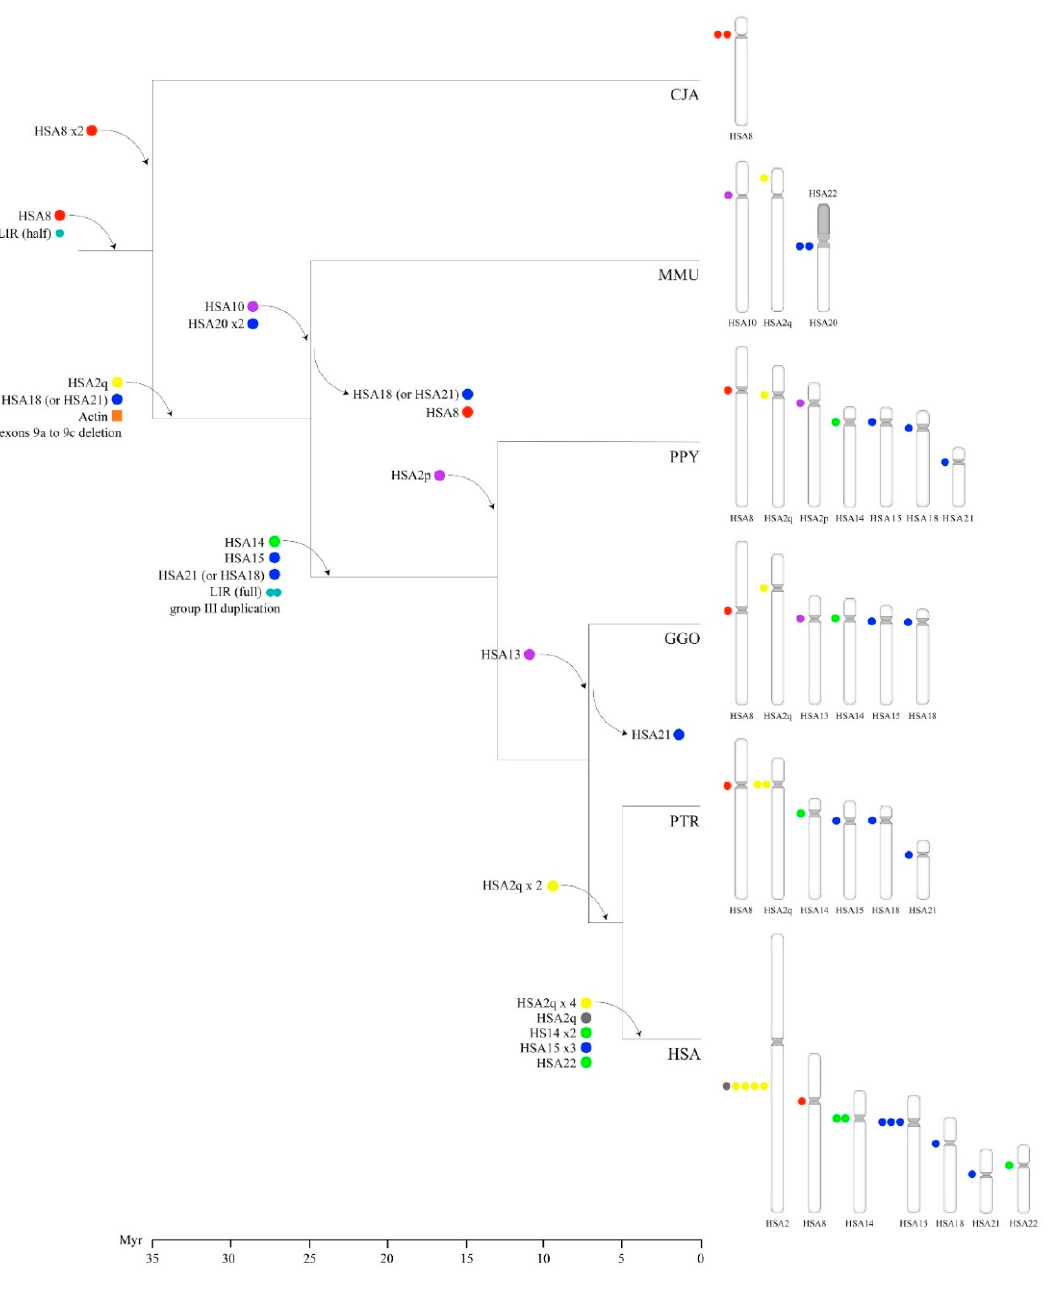
Figure 6. Evolutionary model of the POTE gene family. The emergence of each POTE copy, the actin module fusion, the full-sized LIR, and the group III intraduplication are described. Colored circles indicate the four different groups: red for group I, blue for group II, yellow for group III, and green for group IV. Purple circles represent POTE paralogs that have not been assigned to specific groups due to the lack of sequence data.